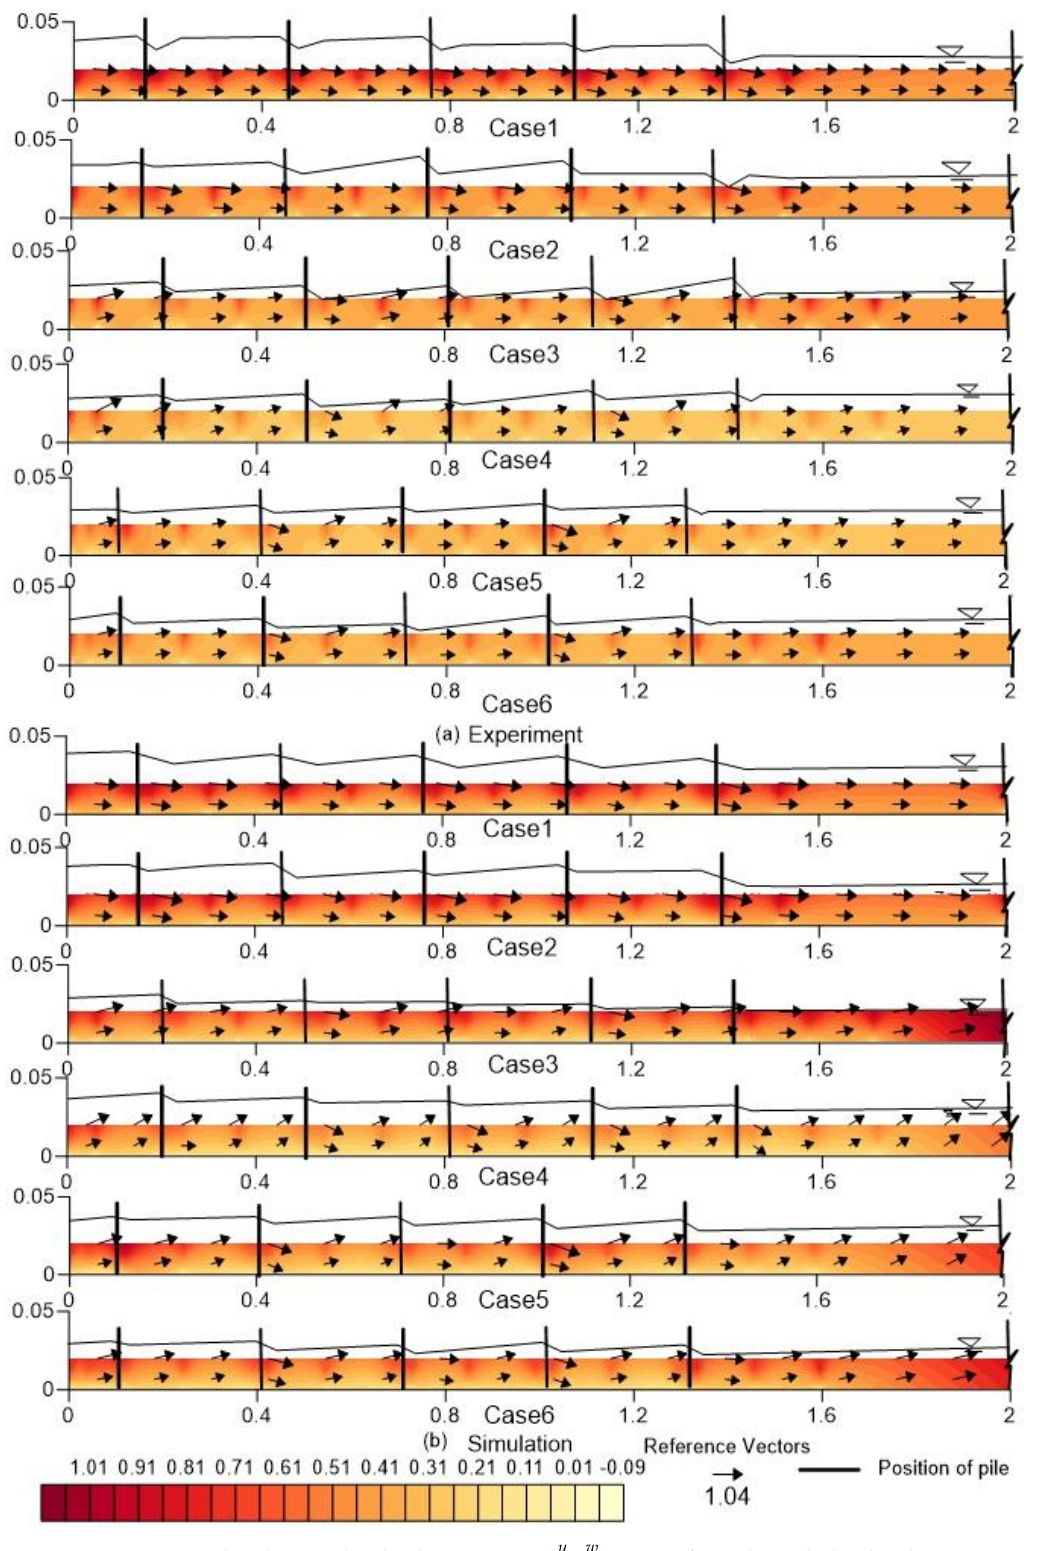
Figure 7. Dimensionless longitudinal velocity vector ( u shows the variation of the longitudinal velocity component (